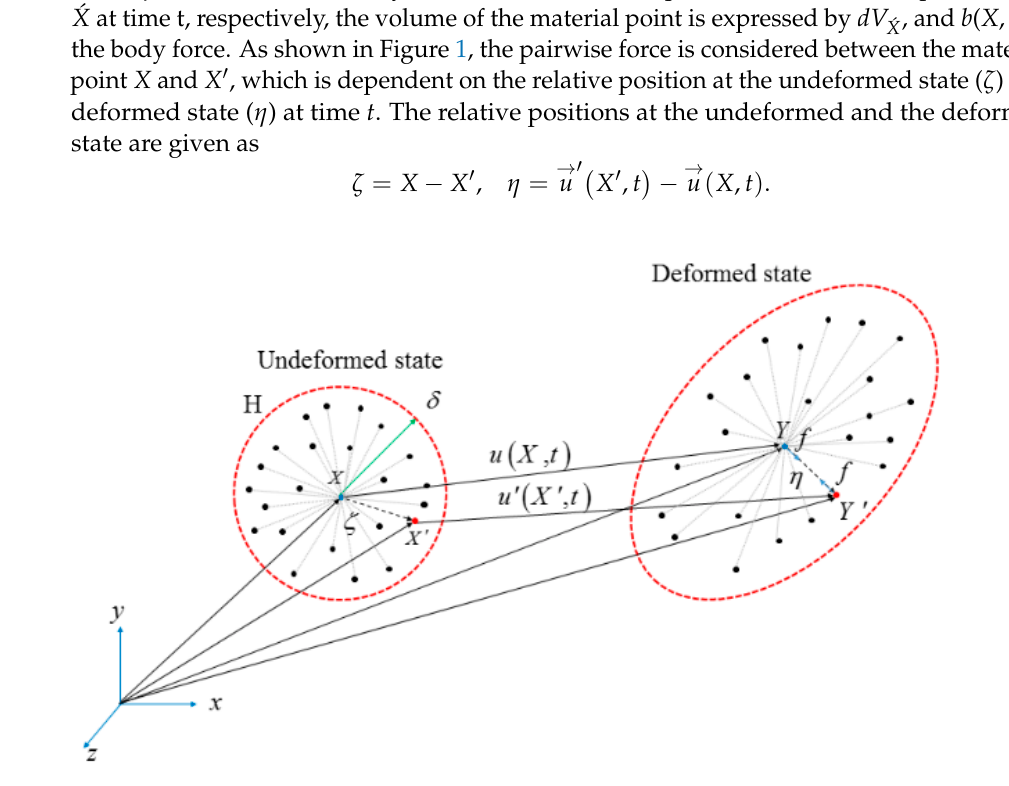
Figure 1. Undeformed and deformed state configuration of X and its family member. → f is defined as the following The pairwise force vector